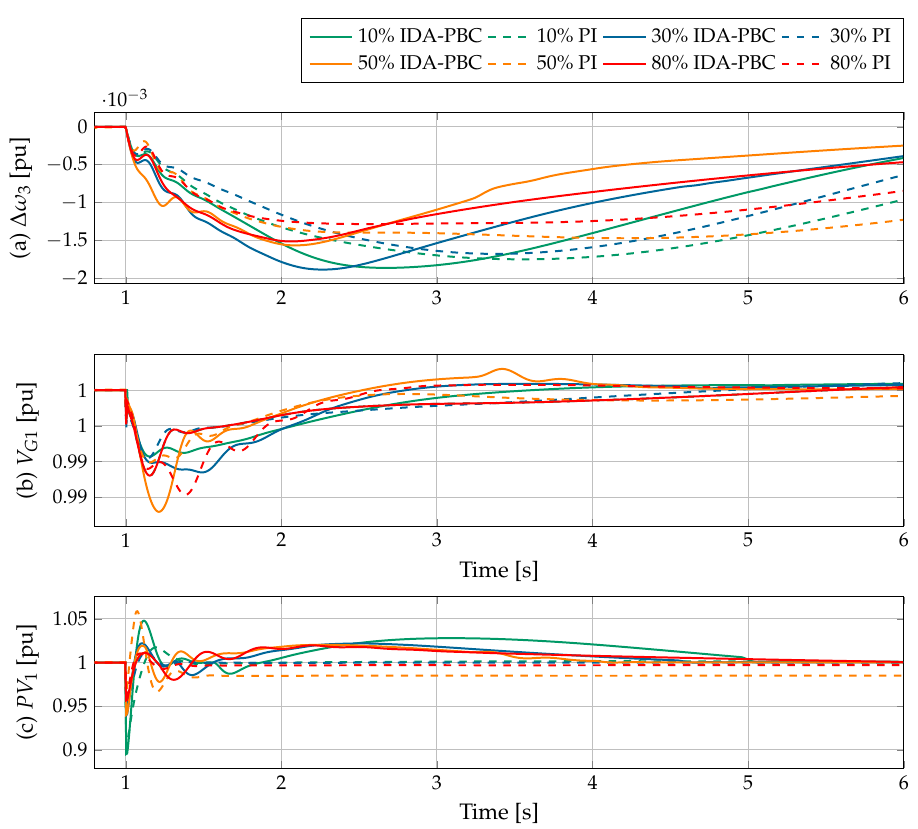
Figure 10. Response of the test system to the abrupt connection of a load at bus 5: ( a ) rotor speed of generator 3, ( b ) terminal voltage of Generator 1, and ( c ) active power of PV plant